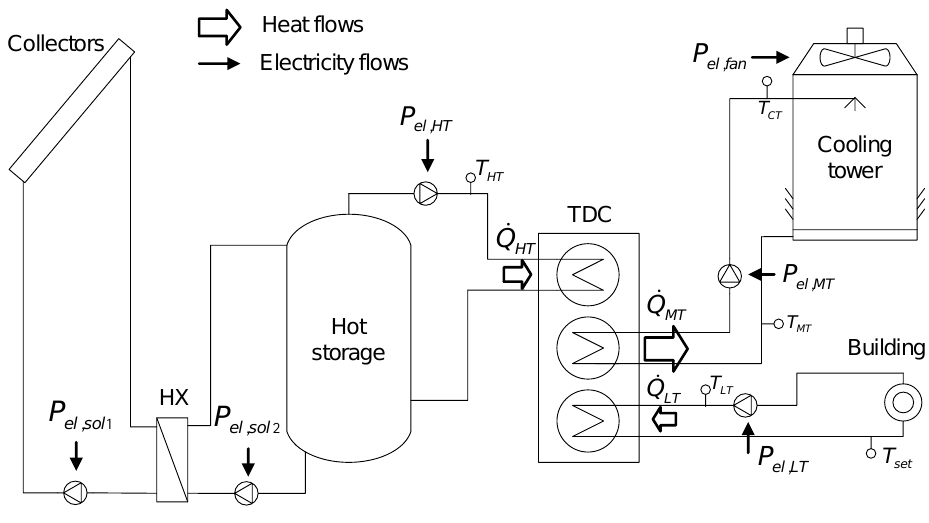
Figure 1. Simplified scheme of a solar thermal cooling plant with the main energy